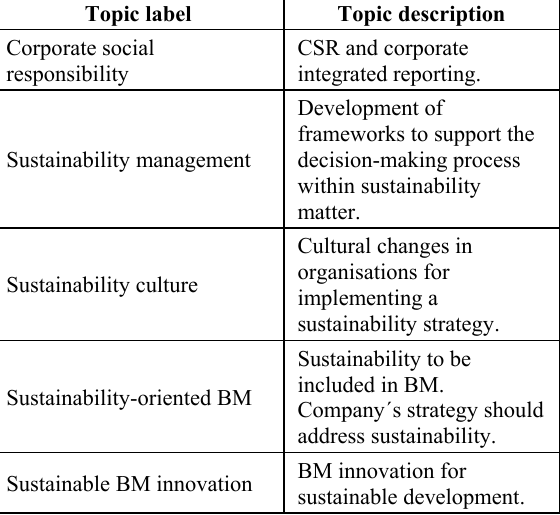
Table 1. Internal enablers for SBM Topic label